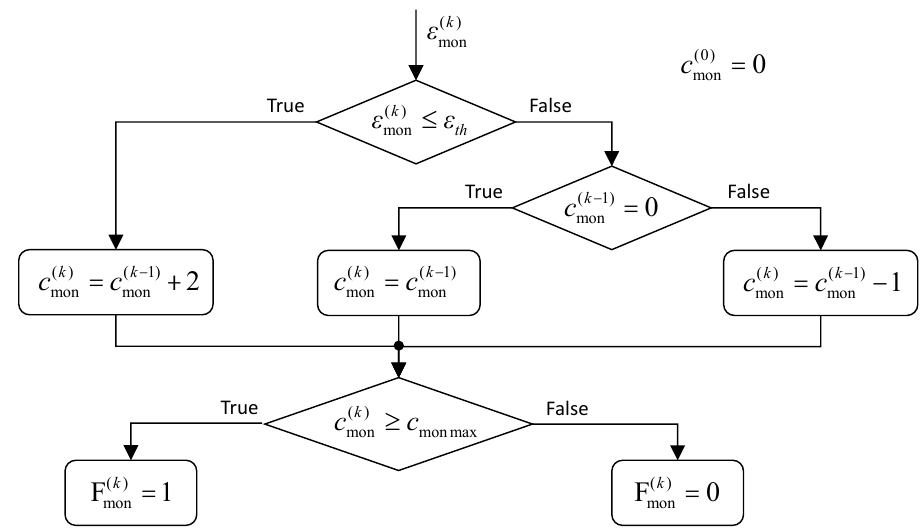
8 of 22 Table 4. Currents Monitor: groups and classes for FDI of sensors and coil faults to the i -th motor. Group